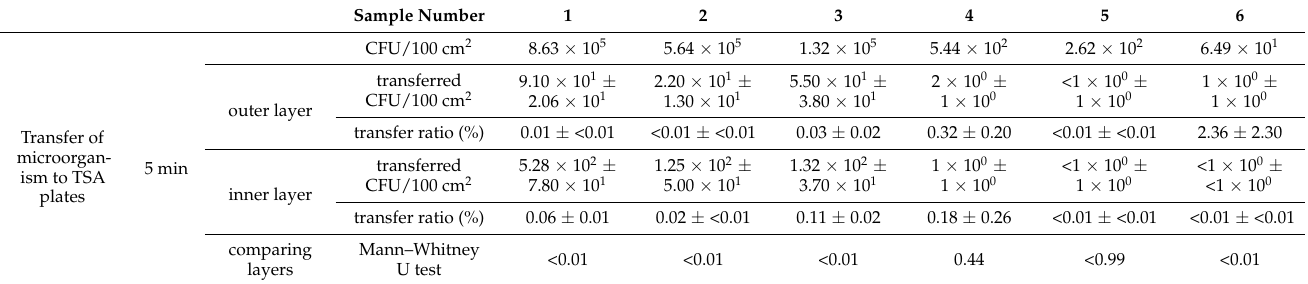
Table 5. Determination of the transfer of microorganisms from the inner and outer layers of tested samples to tryptone soy agar (TSA) plates. The samples are labeled with respect to their numbers of colony-forming units per 100 square centimeters (CFU/100 cm 2 ) in descending order (1–6). The exper- imental set-up was performed as described in Figure 2(3). Data are shown as mean ± SD. The transfer ratios are declared as a percentage (%). A p -value of <0.05 was defined as statistically significant.